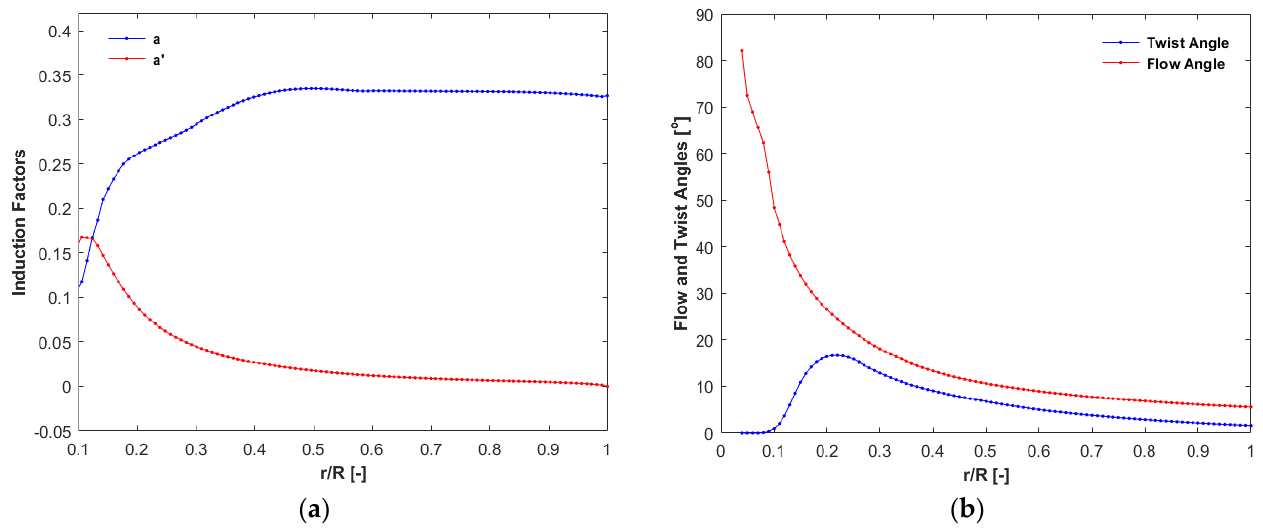
Figure 6. Element induction factors and angles along the normalized blade radius at a wind speed of 10 m/s. ( a ) Induction factors vs. normalized radius. ( b ) Twist/flow angles vs. normalized radius.